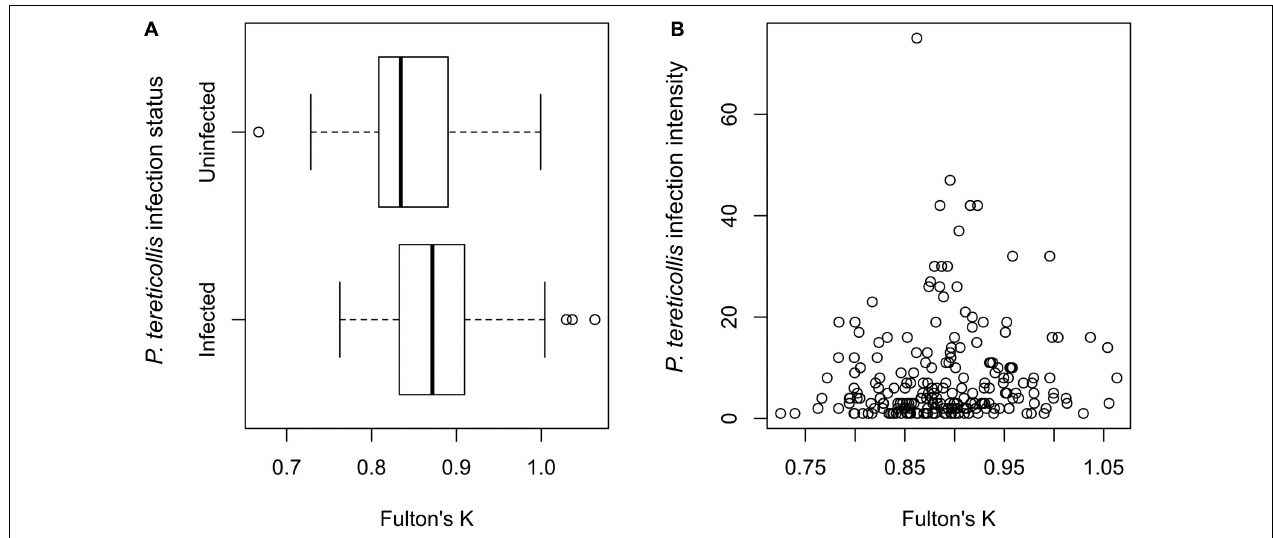
FIGURE 3 | (A) Boxplot of infection status (i.e., whether individual smolts contain P. tereticollis or not) vs. Fulton’s K (condition factor) ( n = 312) and (B) scatterplot of individual infection intensity (i.e., the number of P. tereticollis per infected smolt) vs. Fulton’s K ( n = 218). Data include smolts sampled in 2016, 2017, and 2018.